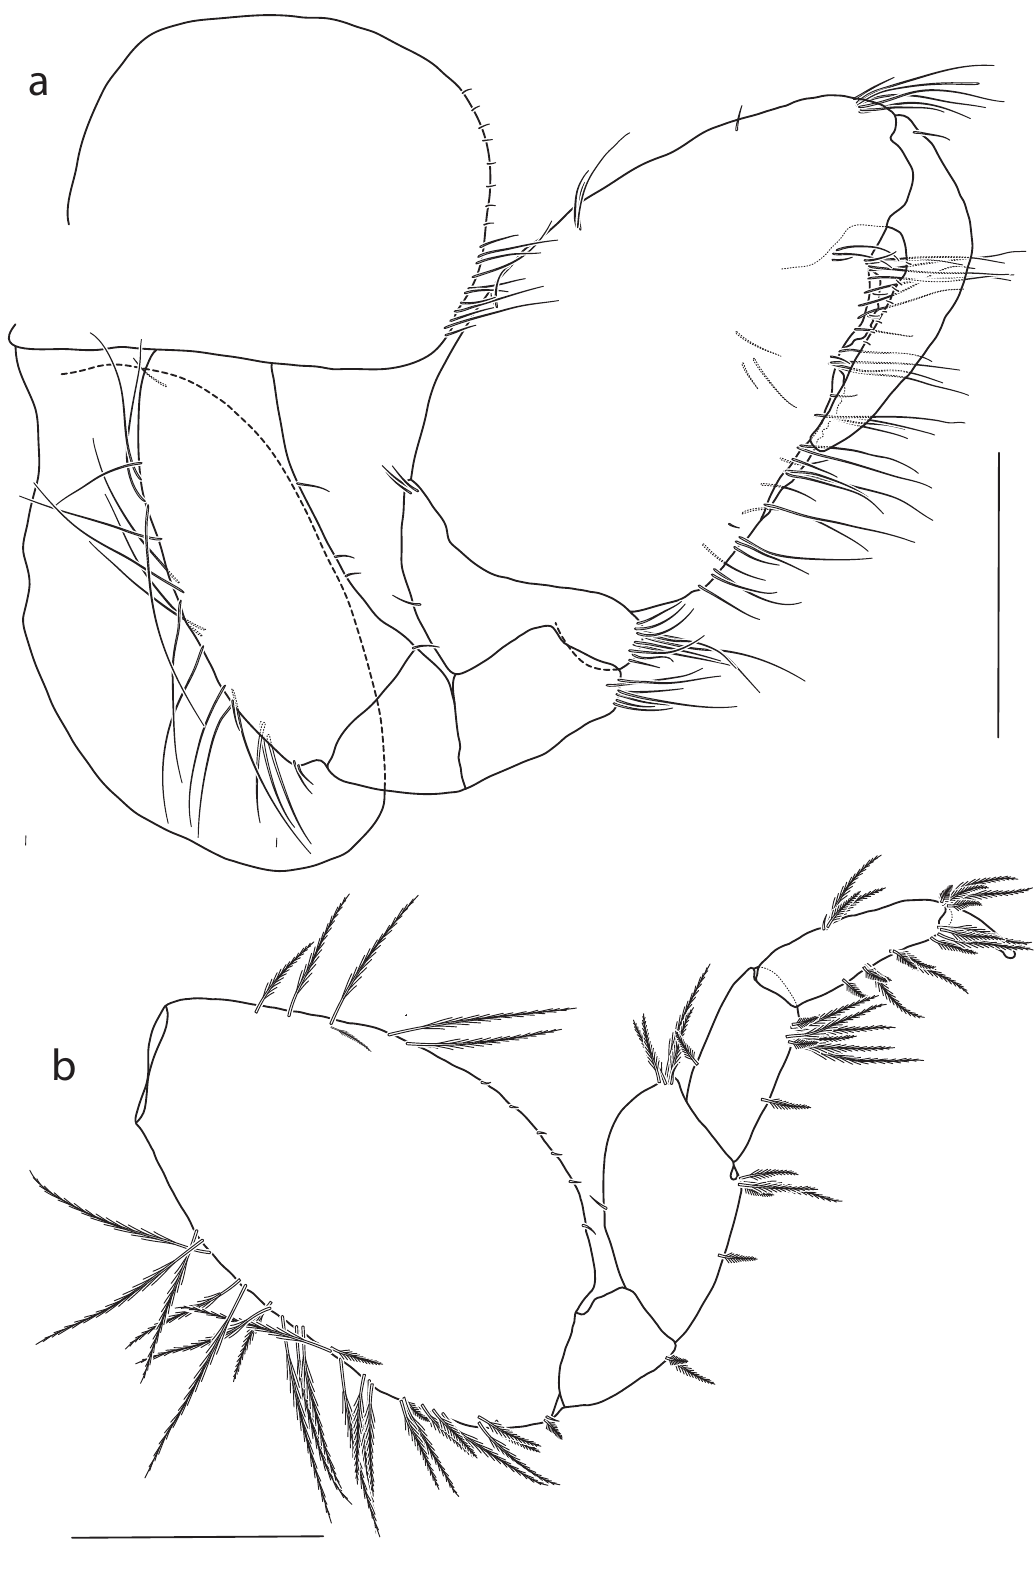
Fig. 4. Sunamphitoe femorata (Krøyer, 1845), ♂, 12 mm (ZMB 34100). a . Gnathopod 2. b . Pereopod 3. Scale bars = 500